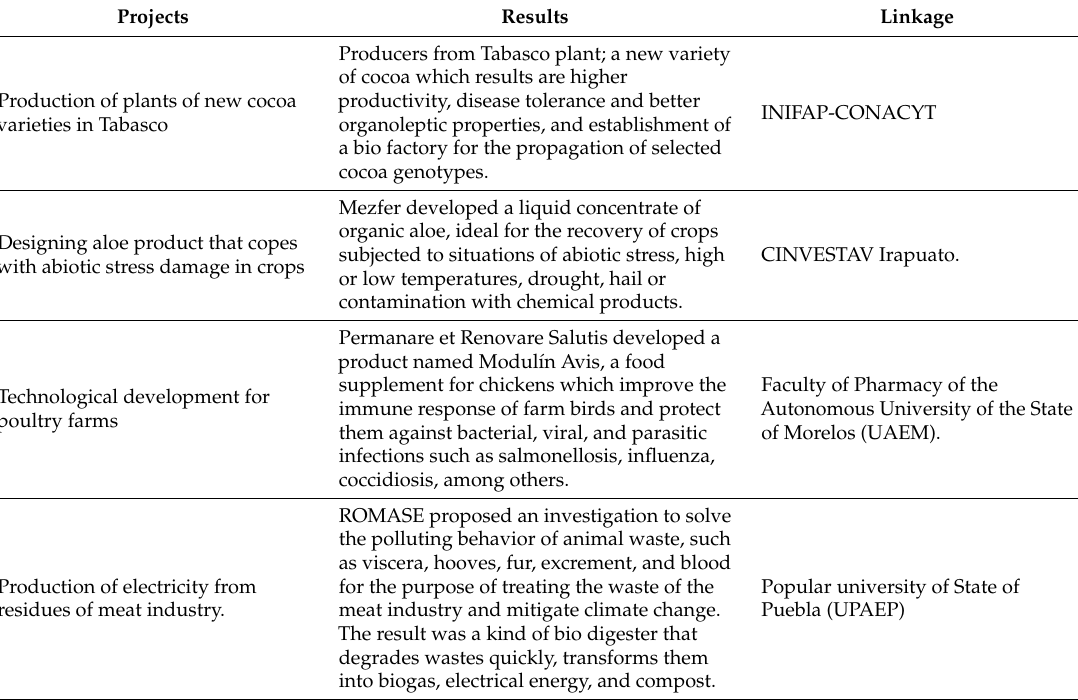
Table 2. Cases of technological transfer in Mexico. Projects supported by Sciences Advisory